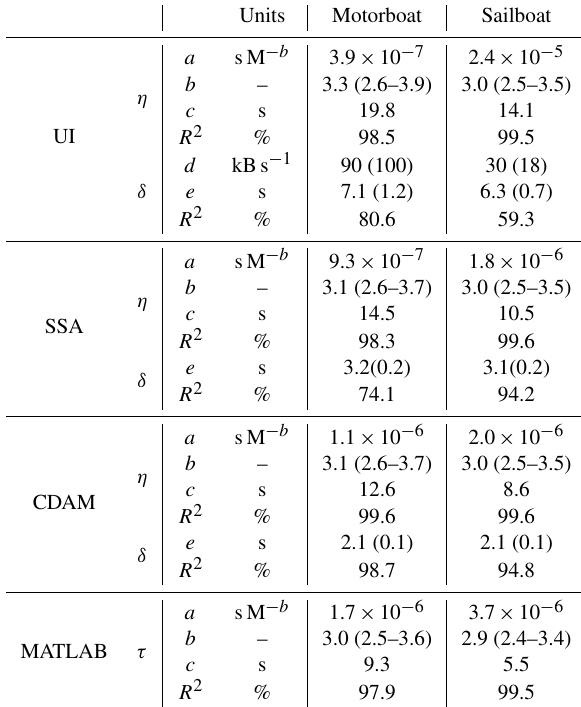
Table 3. Parameters and scores for the least-square fits shown in Fig. 5. For the η and τ signals (a, c panels of Fig. 5) all fits are of type ax b + c , while for the δ signals (b, d panels of Fig. 5) the fits are of type dx + e . The b exponent is given with the 95% un- certainty bounds, while the e intercept is given with the estimated variance (among brackets). Least- χ 2 linear fits (Fig. 5b, d) employ formulas provided in Flannery et al. (1992, chap. 15) for the coeffi- cients of the linear regression and their uncertainties. M = nautical mile = 1850m; kB =